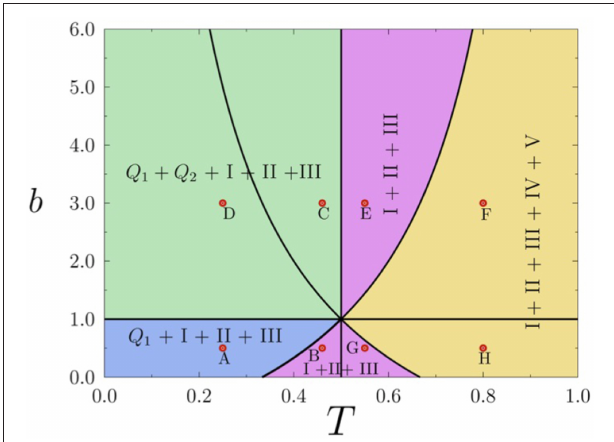
FIGURE 2 | Domain of existence of the different asymptotic solutions in the Asymmetric Coordination Game (ACG) as a function of the threshold T and the risk parameter b as obtained from the analytic solution of the equations discussed in the Appendix. The two curves ( T = 1 + b 3 + b and 1 − T = 1 + b 3 + b ) and the two lines ( b = 1, T = 0.5) divide the figure in eight zones from (A) to (H). In each of these zones the asymptotic solutions that exist are indicated. The red dots correspond to values of T and b used in Figure 5 .